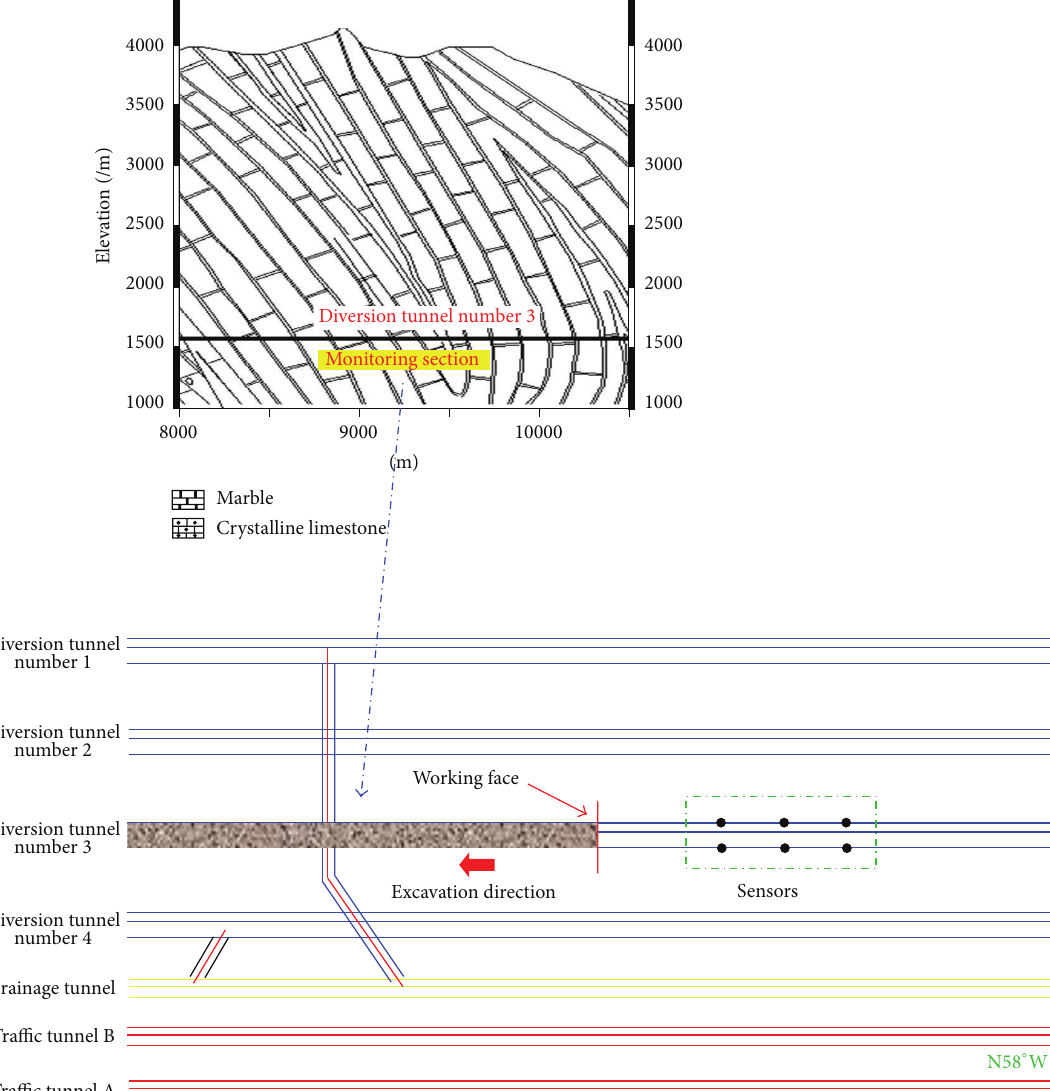
Figure 6: Geological profile of microseismic monitoring area in diversion tunnel #3 of the Jinping II Hydropower Station.